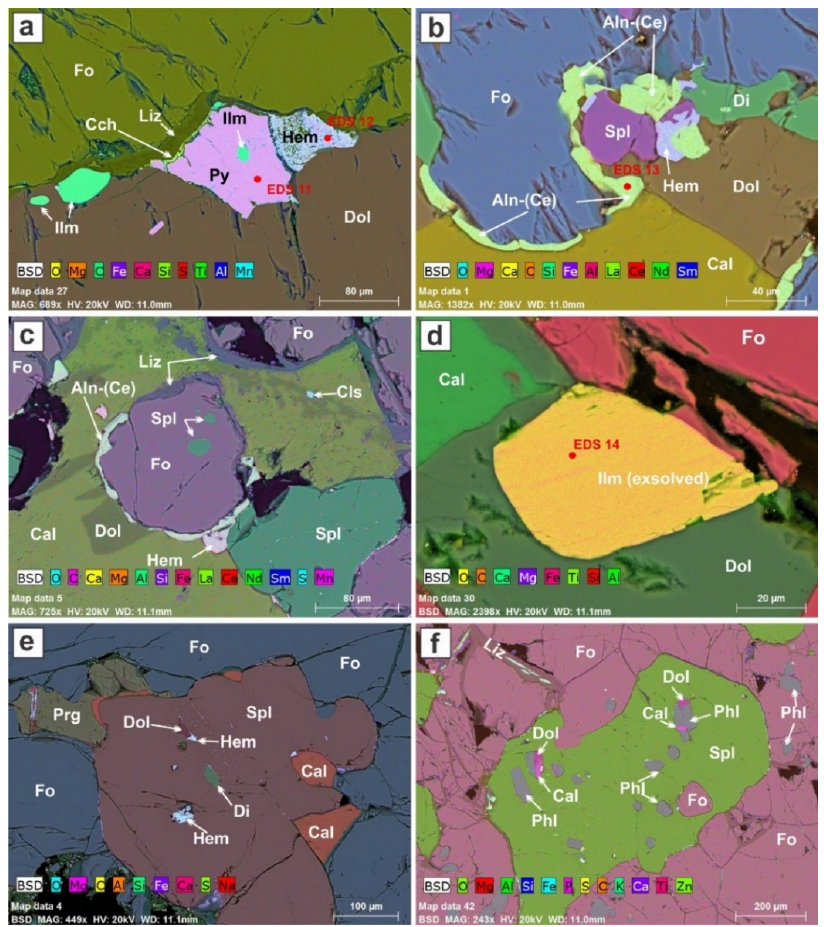
Figure 5. False-color EDS element-distribution maps of interstitial minerals and micro-inclusions in the spinel crystals of the dunite. ( a ) Pyrite occurs together with hematite and ilmenite at an interface between dolomite and forsterite. ( b , c ) Allanite-(Ce) and diopside are decorating a portion of a forsterite grain. ( d ) Ilmenite crystal at the interface between forsterite and dolomite. ( e , f ) Spinel crystals with hematite, dolomite, calcite, phlogopite, forsterite, and diopside inclusions. Symbols not yet defined: Aln-(Ce): Allanite-(Ce); Cch: Clinochlore; Ilm: Ilmenite. EDS point analyses 11 to 14 are shown in Figures S4 and S5.